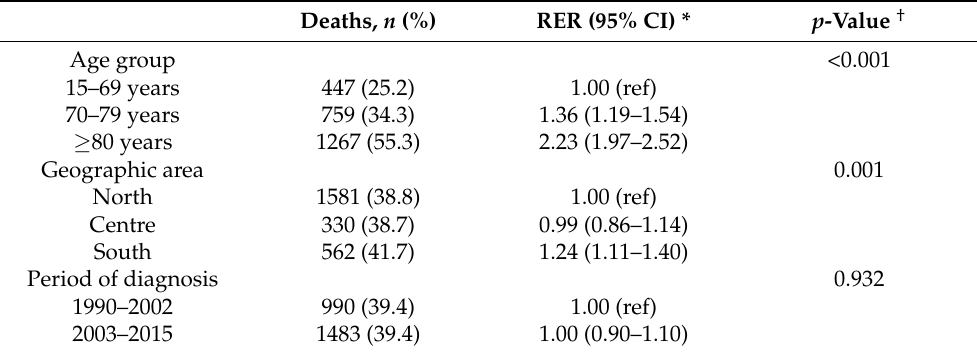
Table 7. Multivariate relative excess risk (RER) of death from vulvar squamous cell carcinoma at